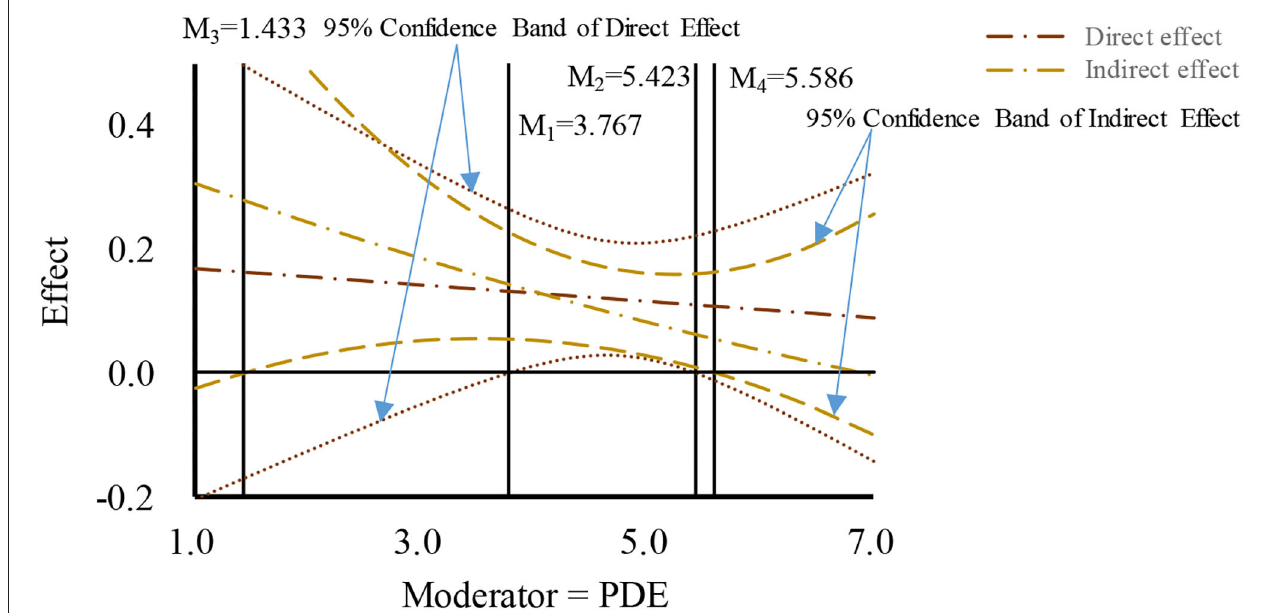
FIGURE 2 | Moderated mediation effect of product